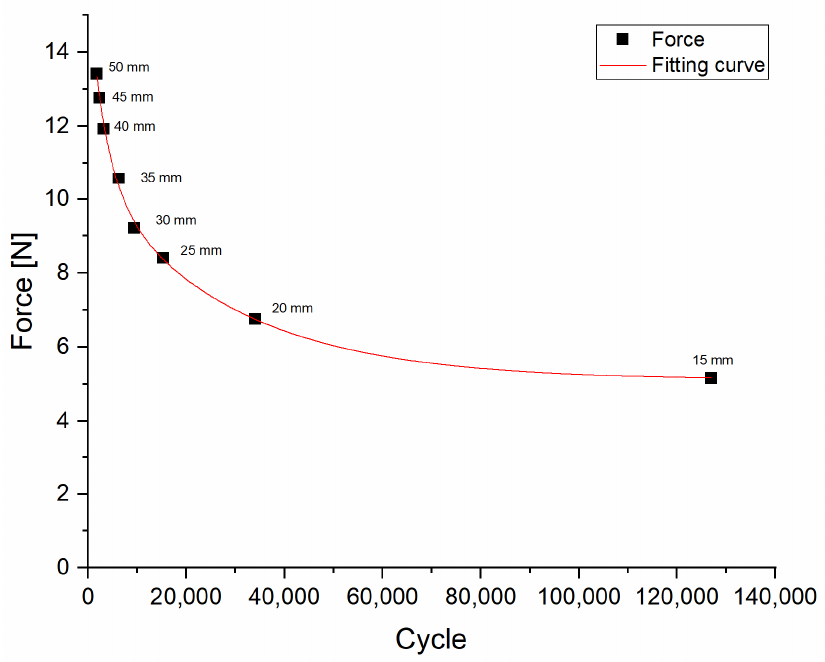
Figure 5. Results of the flexural fatigue test for PLA. The figure indicates the force values measured at the fracture point of each test specimen. The black squares indicate the force values (N) measured at each deflection rate (mm), with the number of cycles needed to break the test specimens.